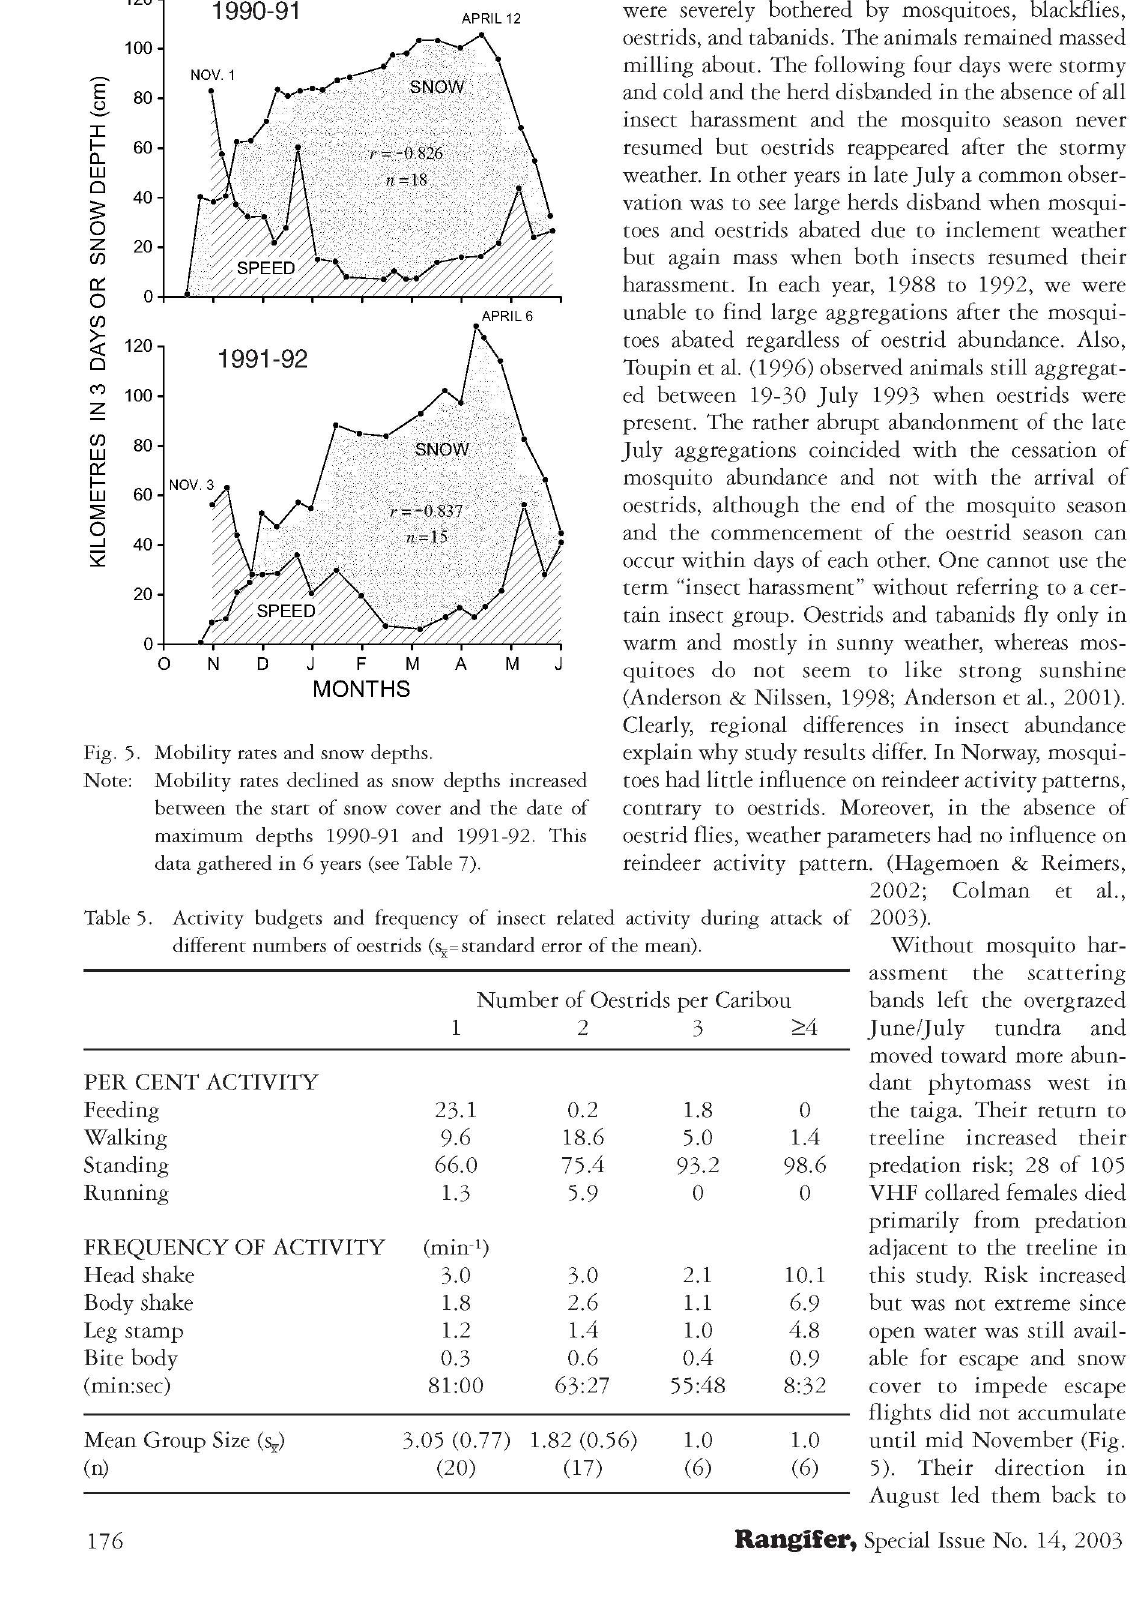
Fig. 5. Mobility rates and snow depths.